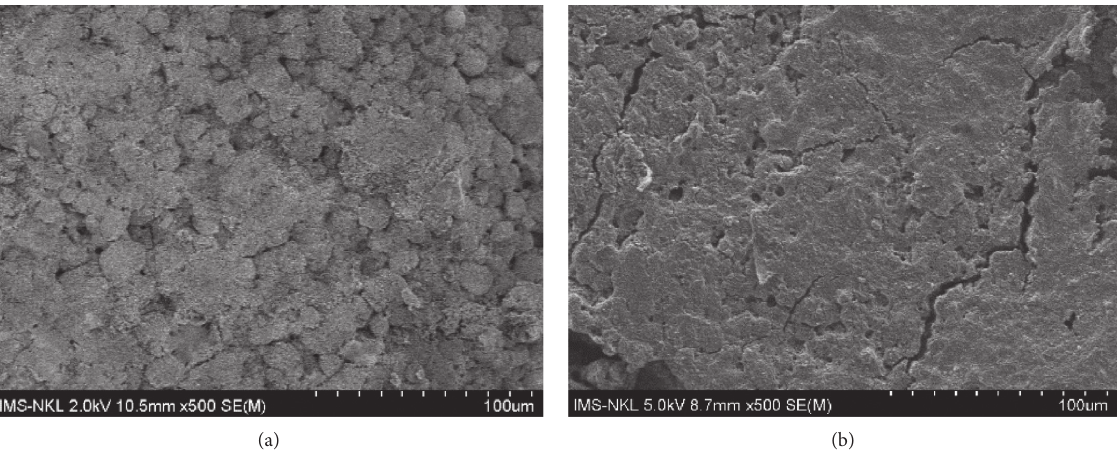
Figure 6: SEM images of the carbon cloth substance (a) and the CI-WATER ink-coated electrode (b).